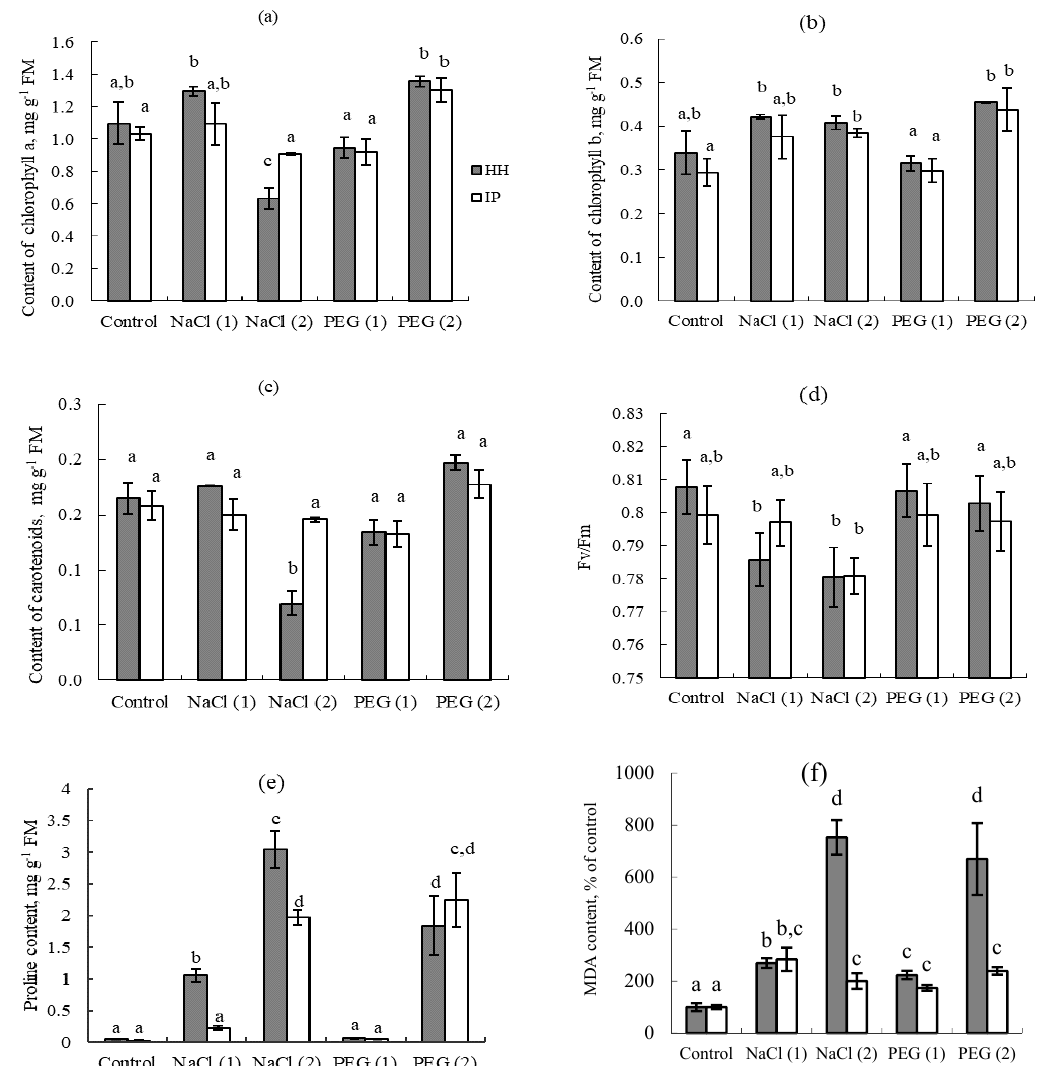
Figure 3. Effects of salt (NaCl) and osmotic (PEG) stresses on the photosynthesis-related characteristics of two improved genetic lines of pearl millet Pennisetum glaucum . The chlorophyll a ( a ), chlorophyll b ( b ), and carotenoid ( c ) contents, the maximum quantum yield of photosystem II ( d ), as well as the proline ( e ) and MDA ( f ) contents, in the leaves from the two pearl millet lines. HH, ‘ HHVBC-Tall ’ line; IP, ‘ IP 19586 ’ line; NaCl (1), 200 mM NaCl; NaCl (2), 300 mM NaCl; PEG (1), 15.8% ( m / v ) PEG 6000; and PEG (2), 18.8% ( m / v ) PEG 6000. The values are means ± SEs. Different letters above the bars represent significant differences at the p < 0.05 level (Tukey’s pairwise comparison).